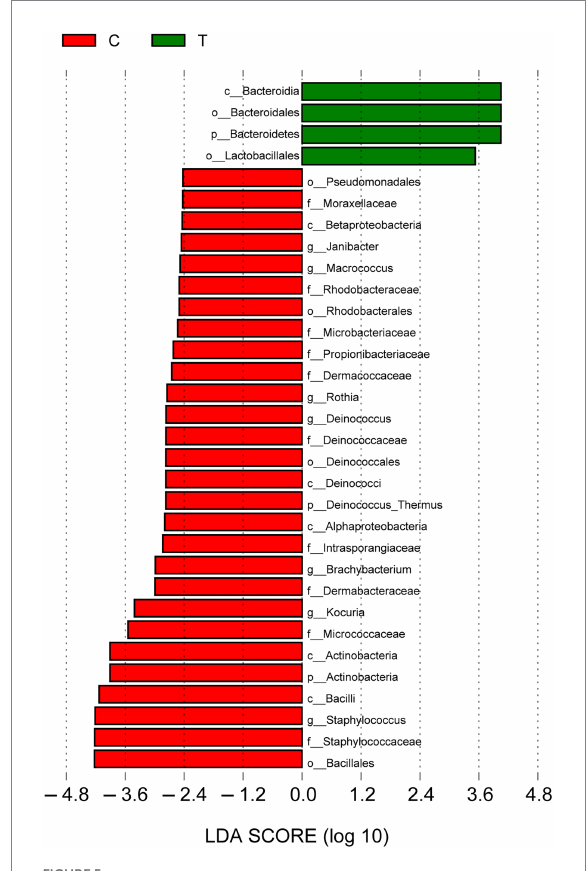
FIGURE 5 Linear discriminant analysis (LDA) effect size results for the bacterial communities of intact skin and wounds. Linear discriminant analysis indicating differentially abundant taxa between skin and wounds. Only taxa with an LDA score > 2.4 and p < 0.05 are shown. p_: phylum, c_: class, o_: order, f_: family, and g_: